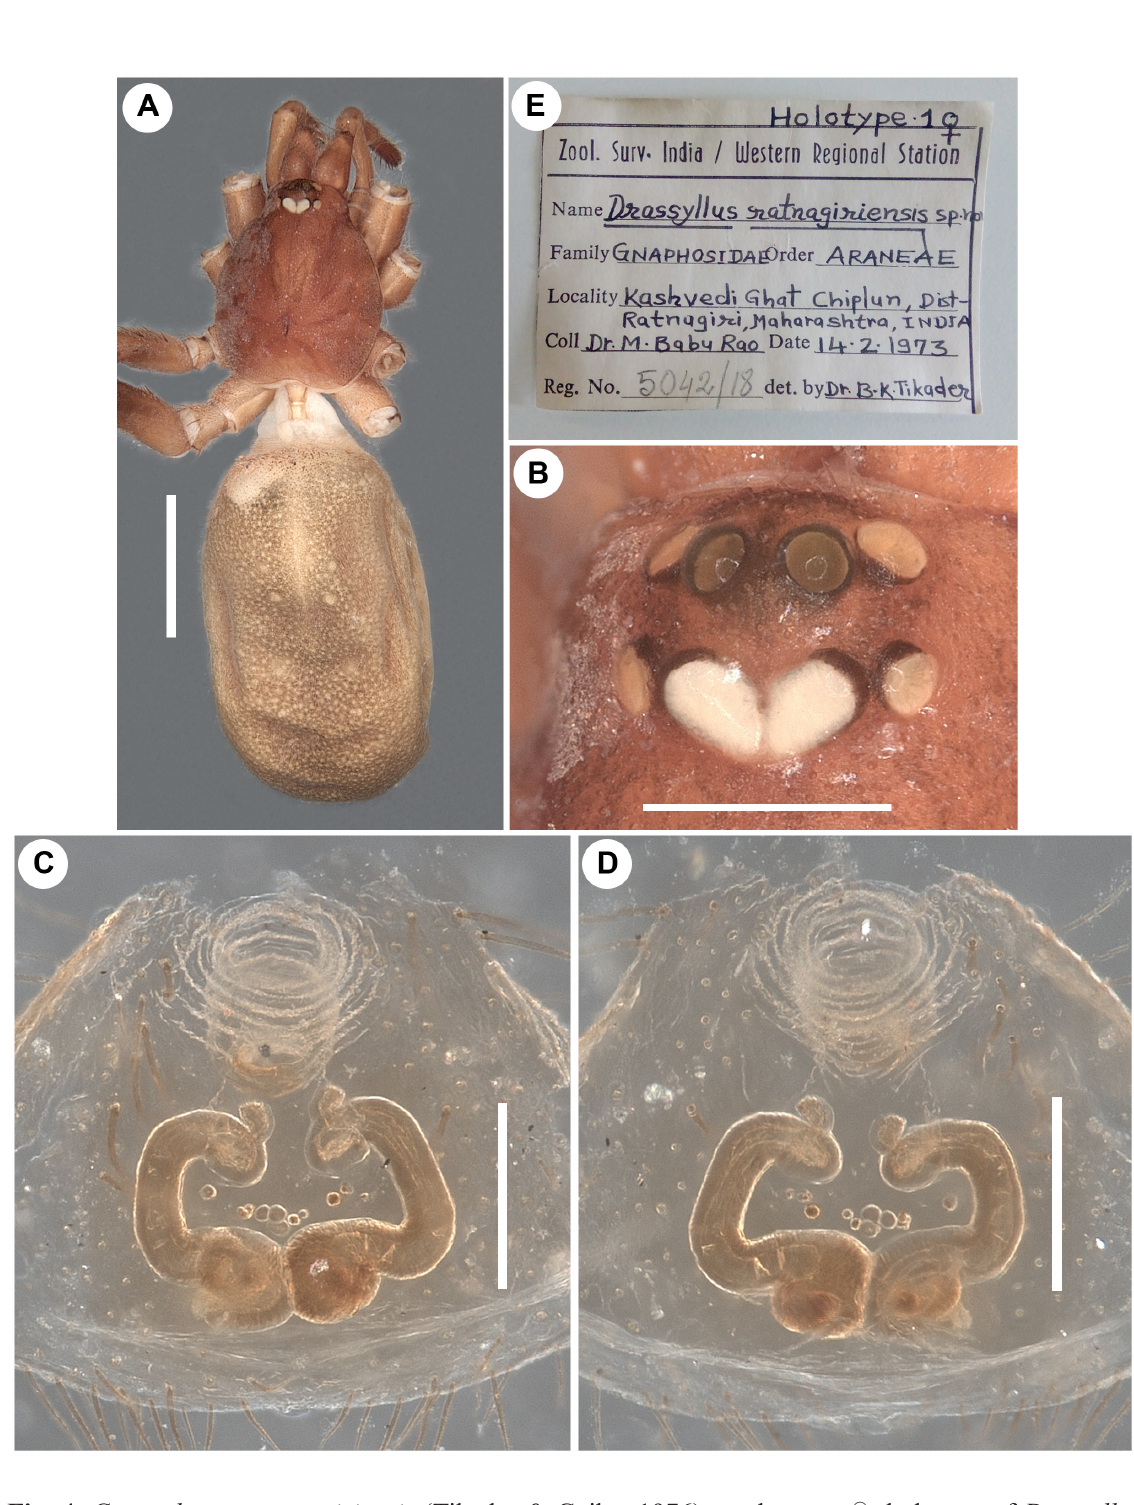
Fig. 4. Cryptodrassus ratnagiriensis (Tikader & Gajbe, 1976) comb. nov., ♀, holotype of Drassyllus ratnagiriensis Tikader & Gajbe, 1976 (NZC-ZSI-5042/18). A . Habitus, dorsal view. B . Eyes of the same, dorsal view. C . Epigyne, ventral view. D . Same, dorsal view. E . Label from type bottle. Scale bars: A = 2 mm; B = 0.5 mm; C–D = 0.2